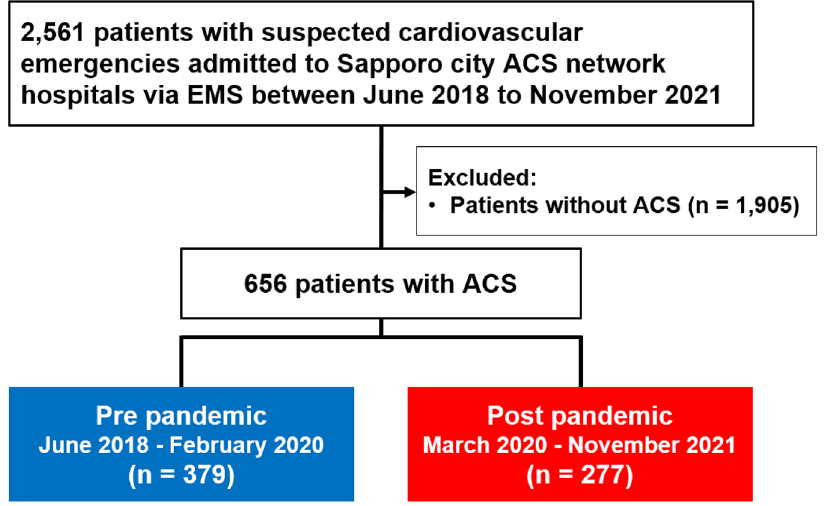
Figure 1. Flow diagram of the present study. ACS, acute coronary syndrome; EMS, emergency medical